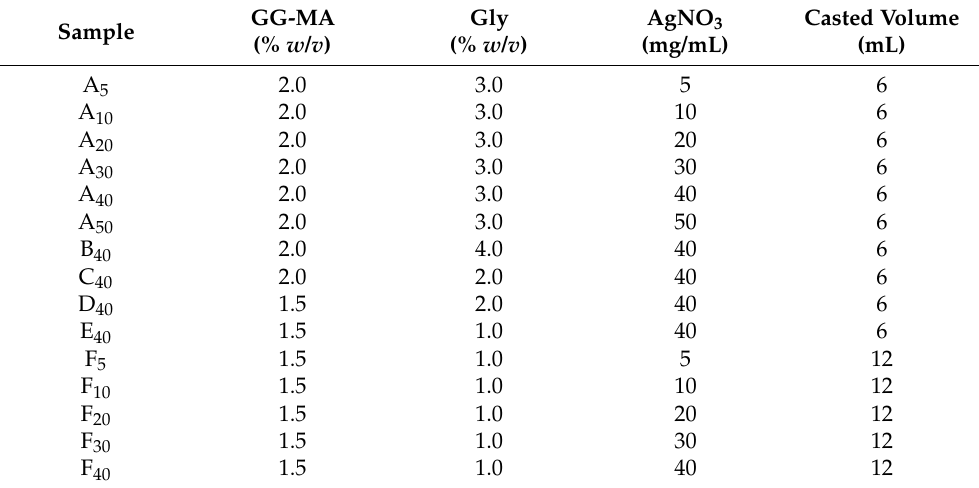
Table 1. Composition of the film-forming mixtures for film preparation. Film samples were labelled with letters (the same letter was used for samples obtained from film-forming mixtures with the same concentrations of GG-MA and Gly) and a subscript, which was used to specify the amount of silver salt included in the formulation. Sample